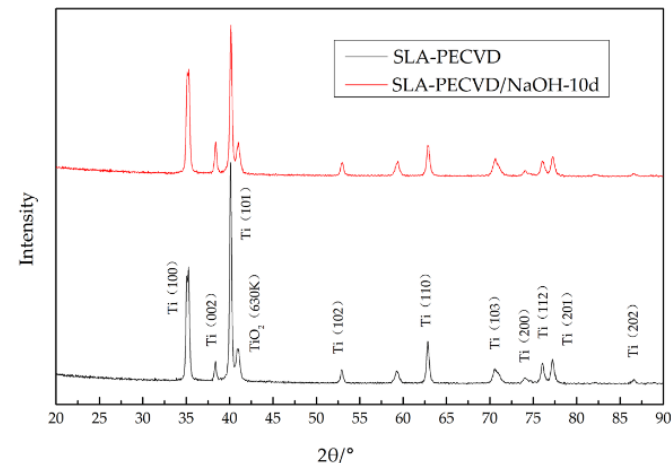
Figure 5. The XRD patterns of SLA-PECVD and SLA-PECVD/NaOH-10d samples. The diffraction peak of TiO x was not detected on the surface of Ti samples by acid etching and plasma oxidation, but the intensity of the diffraction peak of Ti changed.